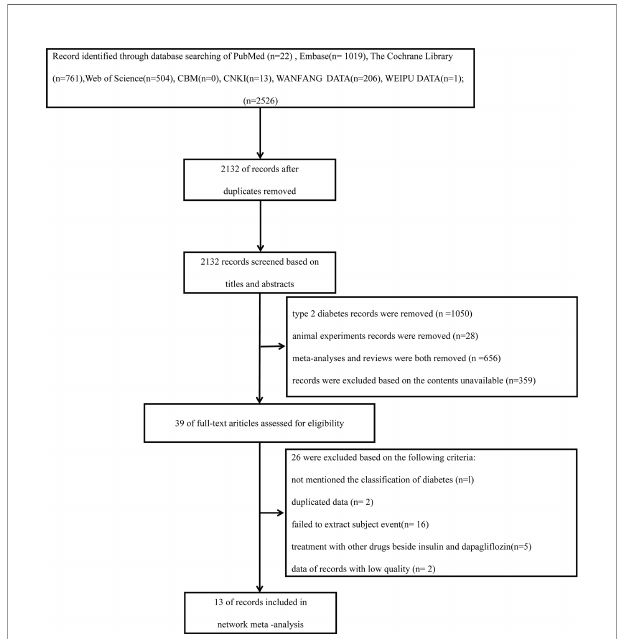
FIGURE 1 | Flow graph of the present systematic review (PRISMA Flow